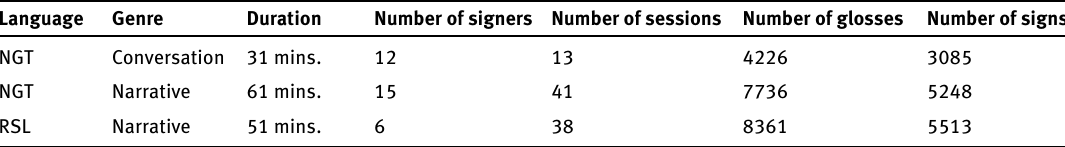
Table 2. Summary of the data set. Number of signs is an approximation based on preferred hand